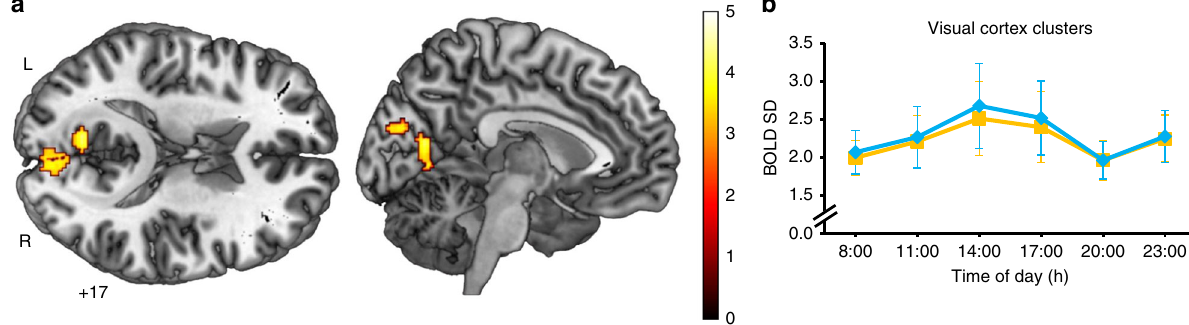
Fig. 3 BOLD SD during visual detection decreases in visual cortex at twilight. a One-sample t -test for BOLD SD during visual detection showing signi fi cant BOLD SD reductions in a cluster in the primary and secondary visual cortex ( k = 112 voxels, P = 0.022, FWE; local maxima in the left calcarine sulcus (MNI − 10 − 68 12) and left lingual gyrus (MNI − 8 − 66 2)) and a cluster in the secondary visual cortex ( k = 184 voxels, P = 0.006, FWE; local maxima in the left (MNI − 2 – 82 24) and right cuneus (MNI 4 − 82 20)) at 08:00h and 20:00 h compared to midday measurements 11:00, 14:00, and 17:00 h (cluster-extent based threshold: k = 112, P < 0.05, FWE corrected; cluster-de fi ning primary threshold of t (40) > 3.31, P < 0.001, uncorrected; n = 9). b Extracted task- related BOLD SD values from the cluster in the primary and secondary visual cortex (yellow) and from the cluster in secondary visual cortex (blue), showing the same ToD-effects as resting-state BOLD SD. Pairwise comparisons between all ToD were not performed on the extracted BOLD SD values to avoid an in fl ation in Type I error 56 . The graph shows the group-mean BOLD SD values for both